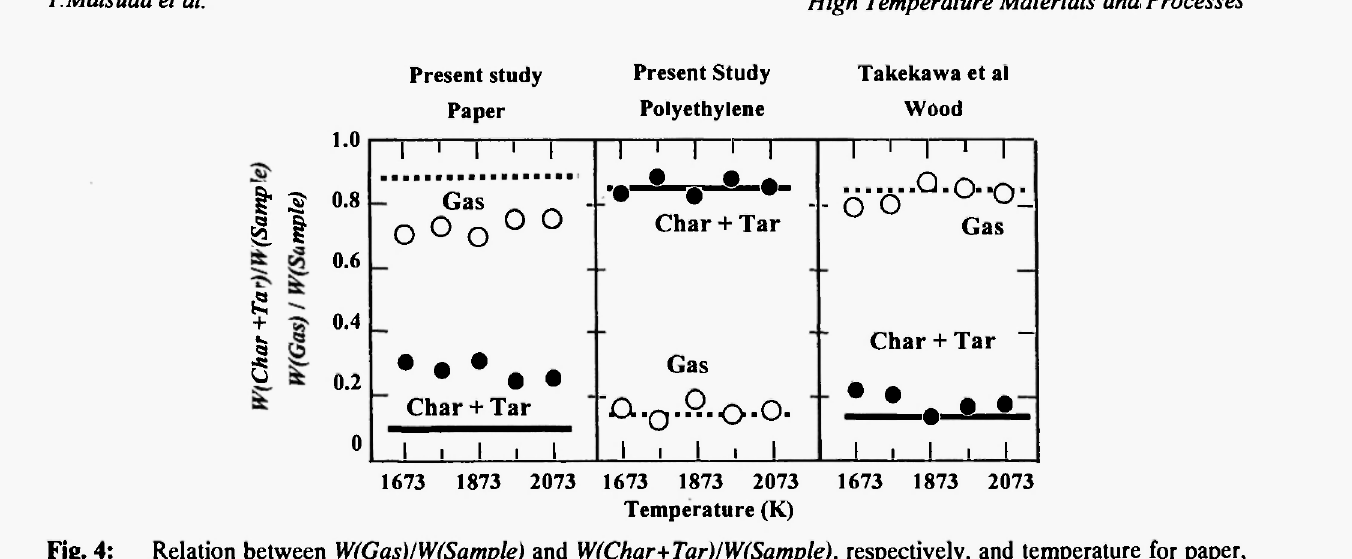
Fig. 4: Relation between W(Gas)/W(Sample) and W(Char+Tar)/W(Sample), respectively, and temperature for paper, polyethylene and wood, respectively. Solid and broken lines indicate, respectively, the calculated values for W(Gas)/W(Sample) and W(Char+Tar)/W(Sample).